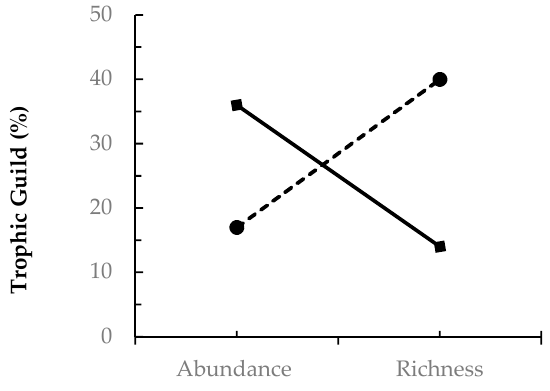
Figure 3. Relationship between relative herbivore ( ) and fungivore ( ) abundance and richness among coleopterans sampled from EAB-impacted (Emerald Ash Borer- impacted) forests.